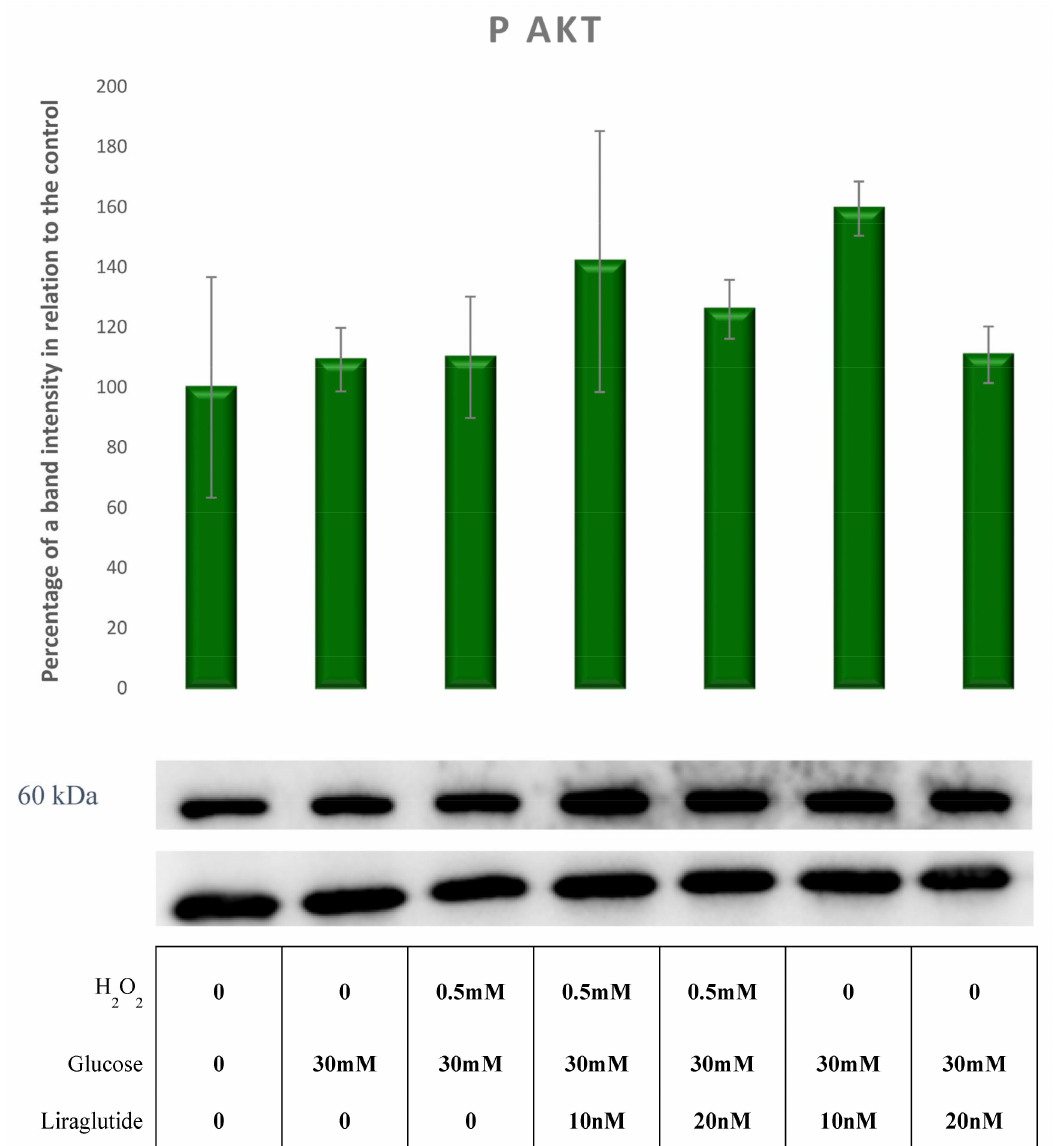
Figure 6. Protein expression in LLC-PK1-treated cell line (control vs. HG30 and HG30/H 2 O 2 ; HG30 vs. HG30/Lira10 and HG30/Lira 20; HG30/H 2 O 2 vs. HG30/H 2 O 2 /Lira10 and HG30/H 2 O 2 /Lira 20) determined by Western blot. Glyceraldehyde 3-phosphate dehydrogenase (GAPDH) was used as an internal control. The data are shown as the means ± SD (standard deviation) from three independent biological replicates. One-way ANOVA F(6,20) = 0.7921, p = 5.91 × 10 − 1 with Tukey HSD post hoc test. Values underneath the x axis represent the amount of compound added in the experiment, and 0 represents that the compound was not added. Protein expression, pig proximal tubule cell line (LLC-PK1), HG (1.5 mM, 30 mM), H 2 O 2 (0.5 mM), Liraglutide (10 nM, 20